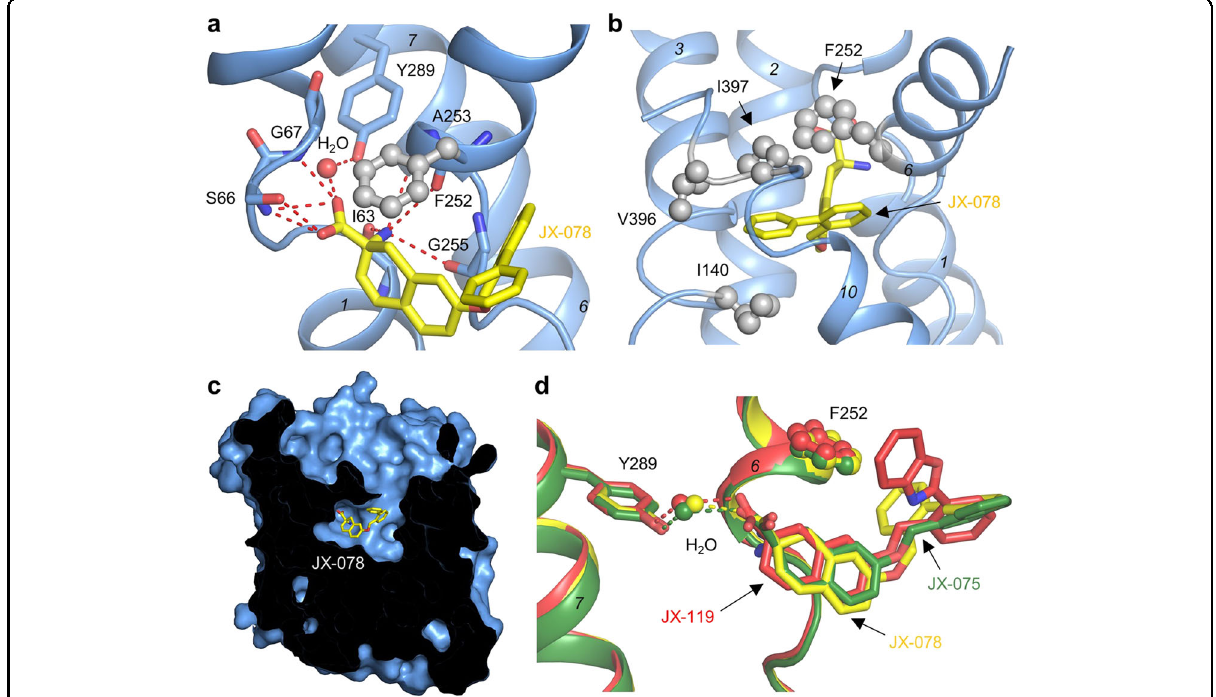
Fig. 2 Inhibitor binding analysis. a JX-078 binding mode in LAT1. b The hydrophobic interactions around the tail of JX-078. c LAT1 has a broad extracellular vestibule above JX-078. d Comparison of the binding mode of the three inhibitors. JX-075, JX-078, and JX-119 are colored green, yellow, and red,